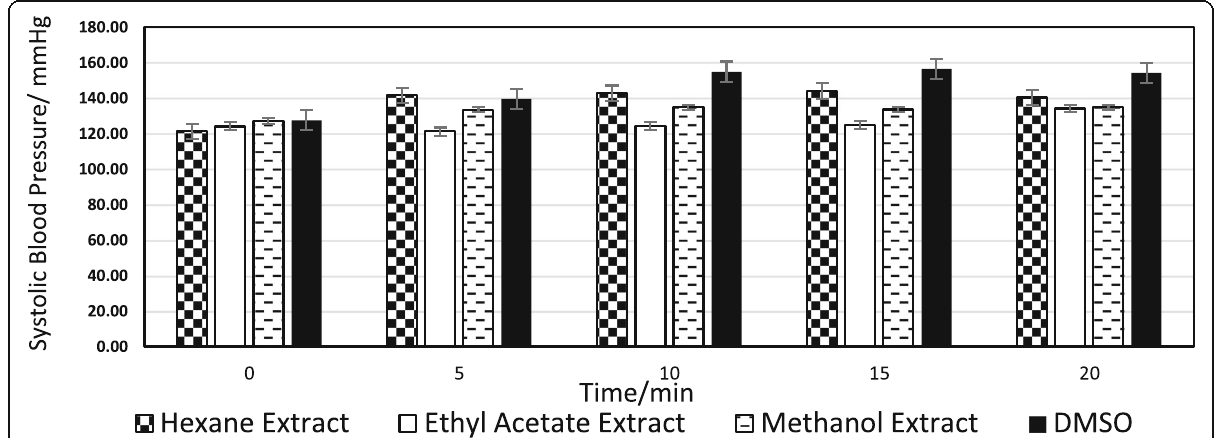
Fig. 3 The effects of the crude extracts of D. canum on systolic blood pressure in normal Sprague-Dawley rats (IV @ 50mg/kg BW). * p <0.05. ** p